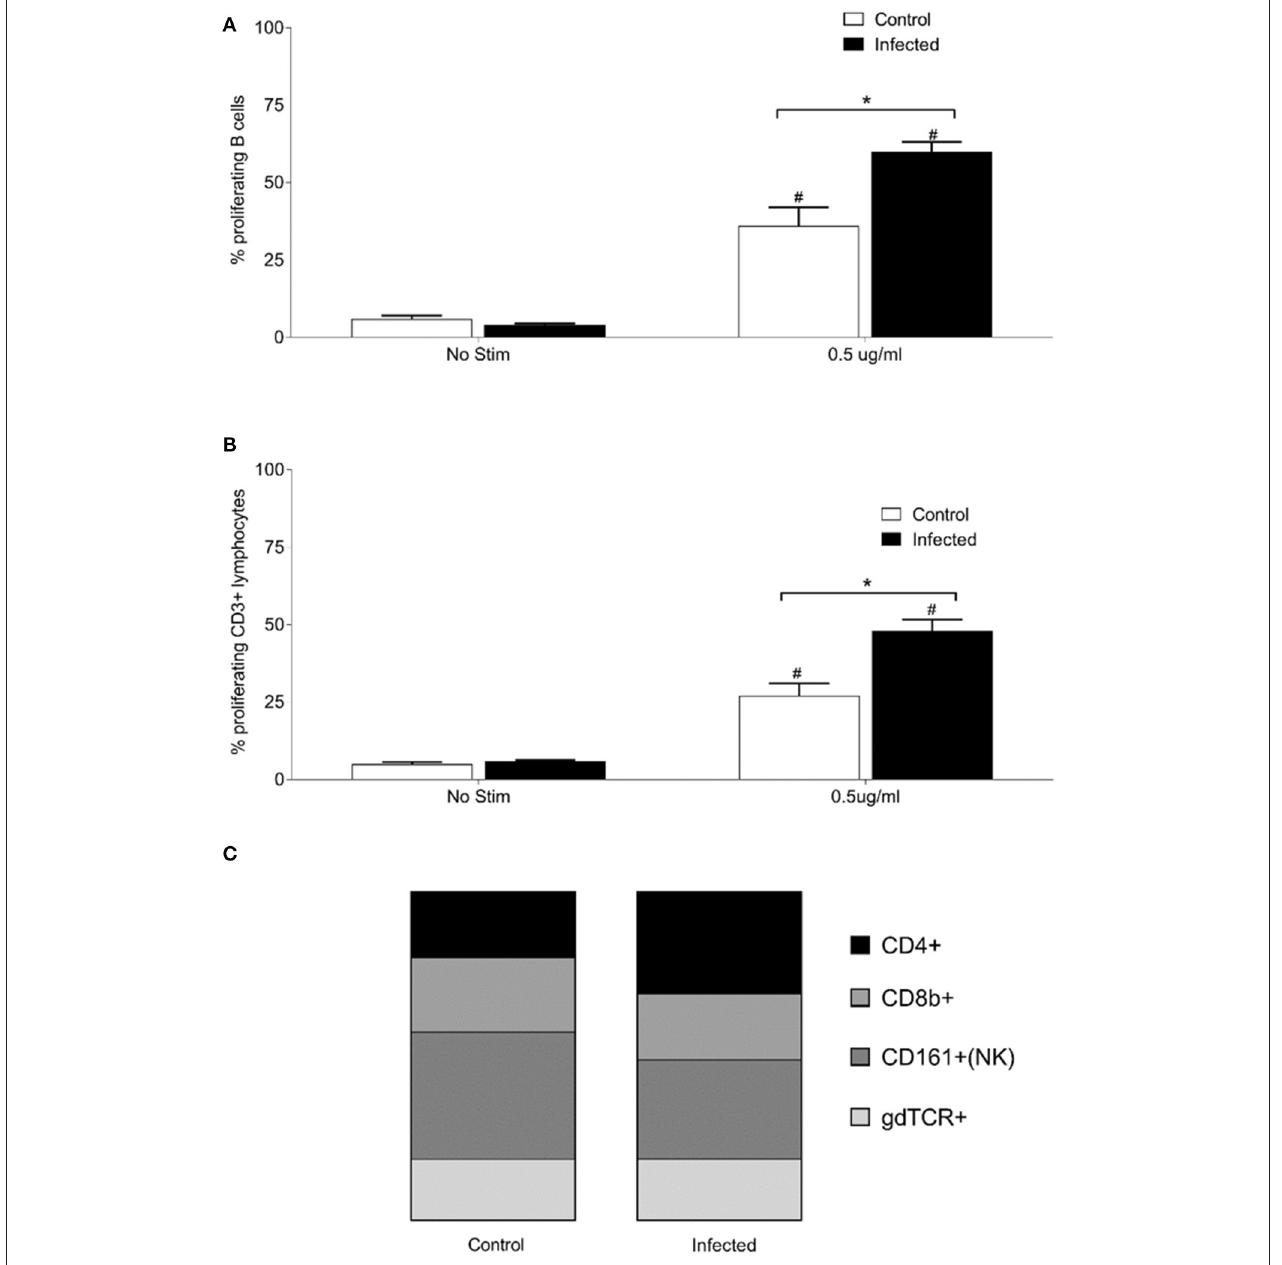
FIGURE 3 | Proliferative responses and cellular phenotypes of lymphocytes isolated from the spleen of 15 infected and nine control rats. Percentage of proliferating B cells (CD3 − , CD19 + , or B220 + ) (A) , percentage of proliferating T cells (CD3 + ) (B) and phenotype by proportion of proliferating CD3 + cells stimulated with 0.5 µ g/ml OM antigen (C) . *indicates statistical significance between infected and control animals; # Indicates statistical significance between OM antigen stimulated wells and no stimulant (No Stim) wells within the same